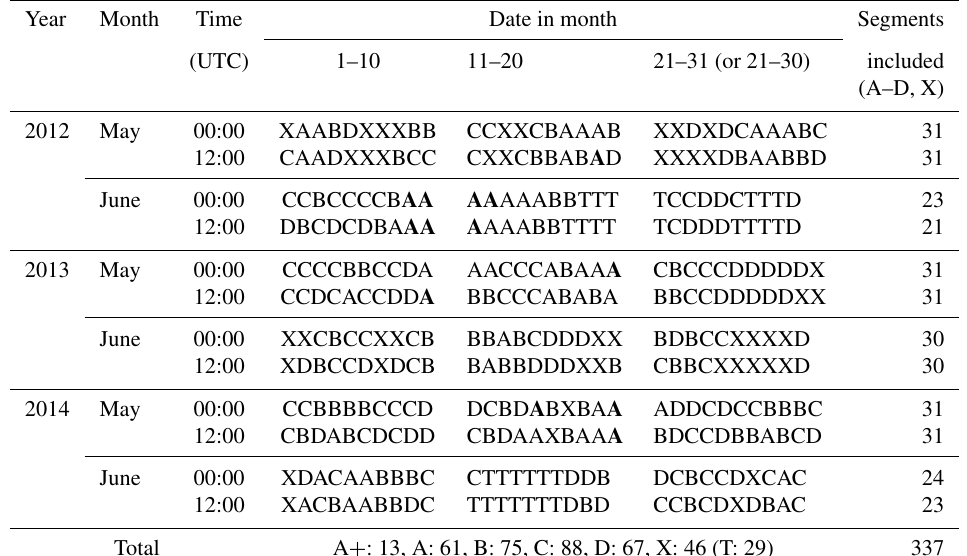
Table 3. The full classification result for all the 24h verification periods during the three Mei-yu seasons of 2012–2014. For each month, the first (second) row gives the results of 00:00–24:00 (12:00–12:00)UTC. While the groups of A–D and X are denoted by their corresponding letter, a bold A indicates group A + (a subset of A), and T marks the periods influenced by tropical cyclones and thus excluded from